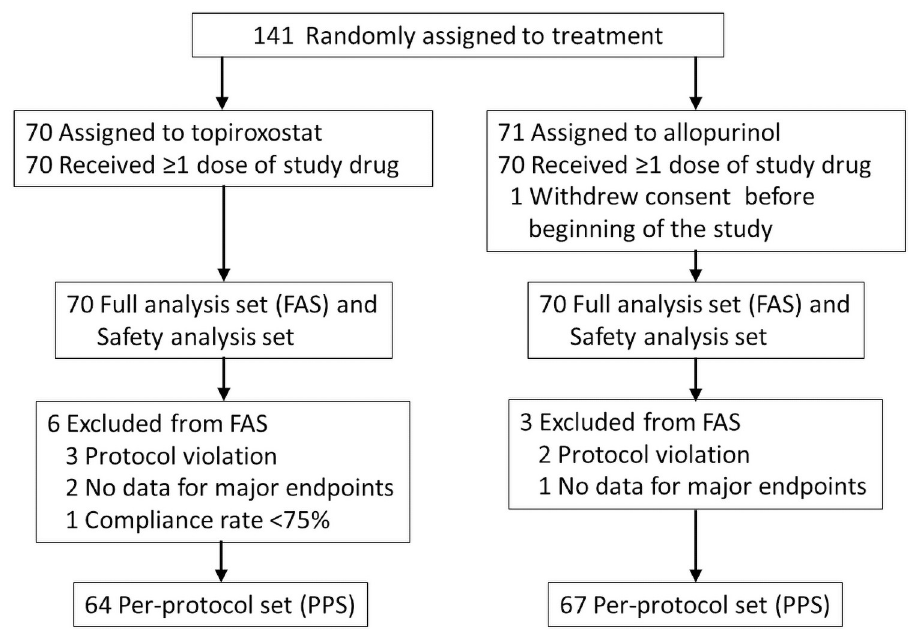
Fig 1. Flowchart of patients enrolled in the excited-UA study. Abbreviations: FAS, full analysis set; PPS, per- protocol set.